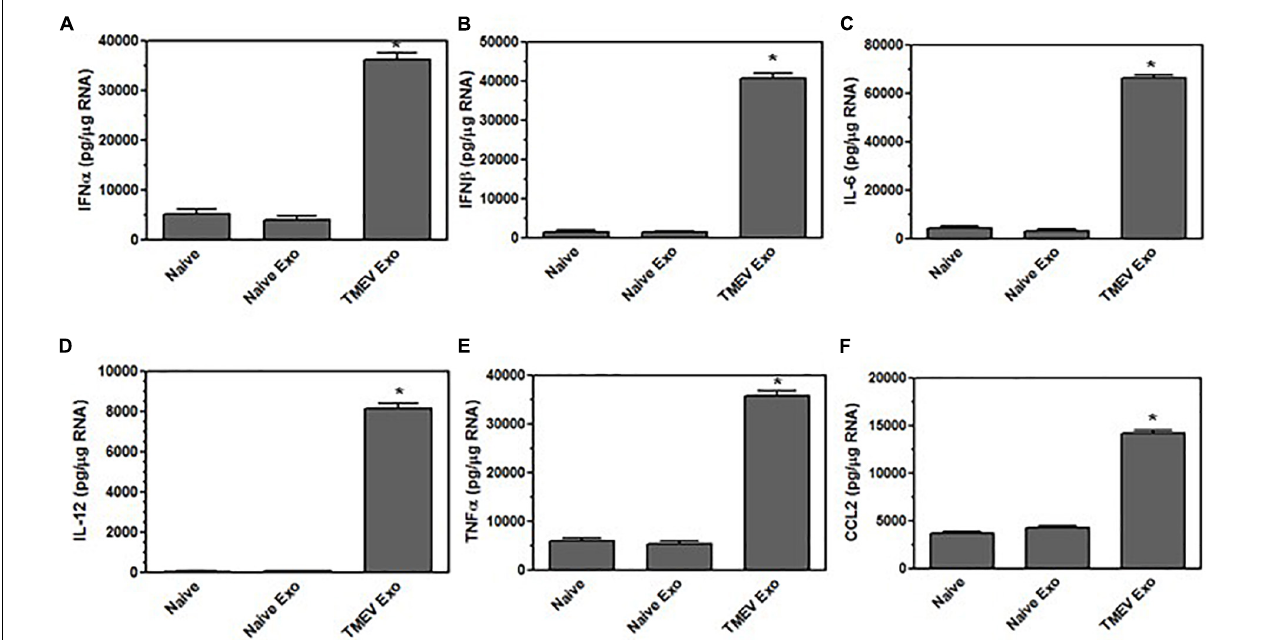
FIGURE 3 | Exosomes from TMEV-infected microglia activate bystander microglia to express type I interferons and pro-inflammatory cytokines. Exosomes were isolated from TMEV-infected microglia or uninfected (naïve) microglia (100 µ g) and placed on naive microglia (1 × 10 6 ) for 24 h. Microglia were lysed, RNA isolated, converted to cDNA, and analyzed by real time PCR for expression of IFN α (A) , IFN β (B) , IL-6 (C) , IL-12 (D) , TNF α (E) , and CCL2 (F) . Significant difference was determined by the one way ANOVA and Bonferroni’s multiple comparison test (* p < 0.001) based on unstimulated microglia. These are representative graphs from one experiment of five independent repeated